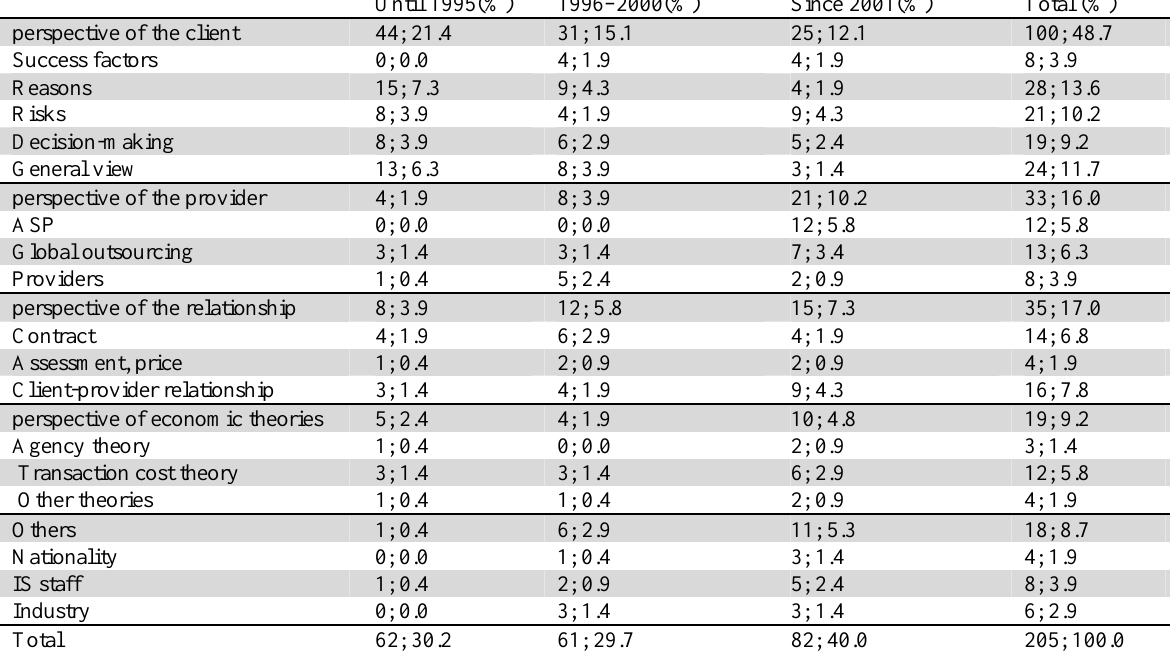
The Chronological and thematic classification of outsourcing